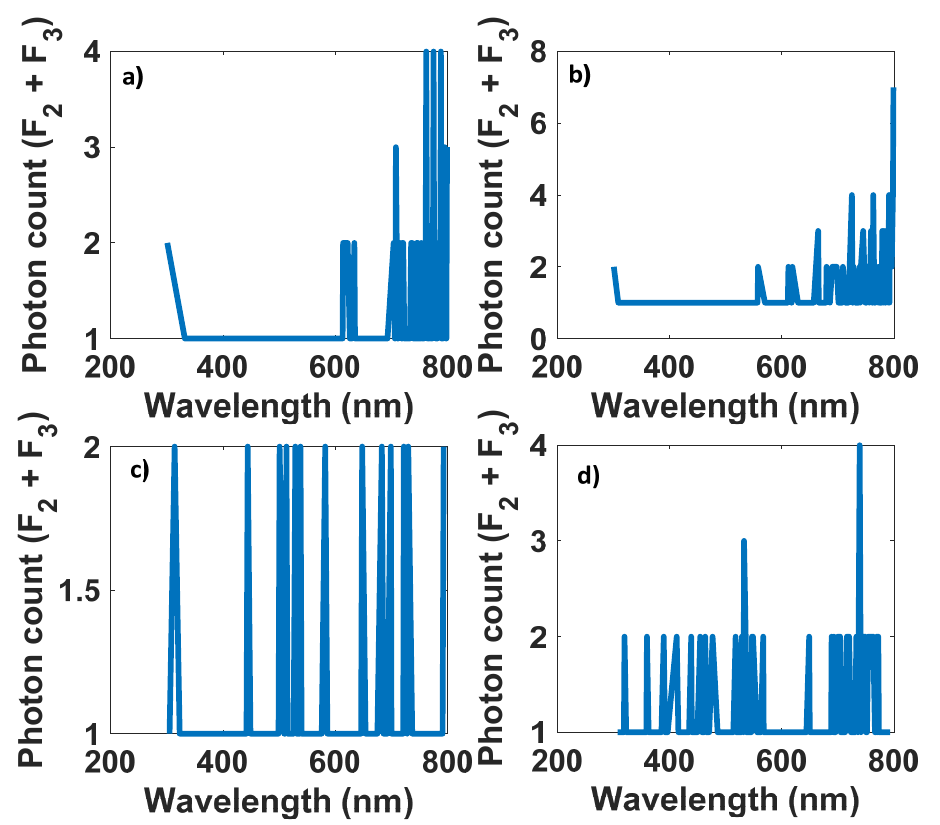
Figure 18. Structures with optical efficiencies lower than 1 (%). ( a ) L = 2 cm, R = 1 cm, QY = 0.3, Concentration = 3.88 × 10 10 (1/cm 3 ), η opt = 0.1700 (%). ( b ) L = 2 cm, R = 3 cm, QY = 0.3, Concentration = 3.88 × 10 10 (1/cm 3 ), η opt = 0.1852 (%).( c ) L = 2 cm, R = 1 cm, QY = 0.3, Concentration = 3.88 × 10 7 (1/cm 3 ), η opt = 0.1160 (%). ( d ) L = 4 cm, R = 1 cm, QY = 0.3, Concentration = 3.88 × 10 7 (1/cm 3 ), η opt = 0.2084 (%).